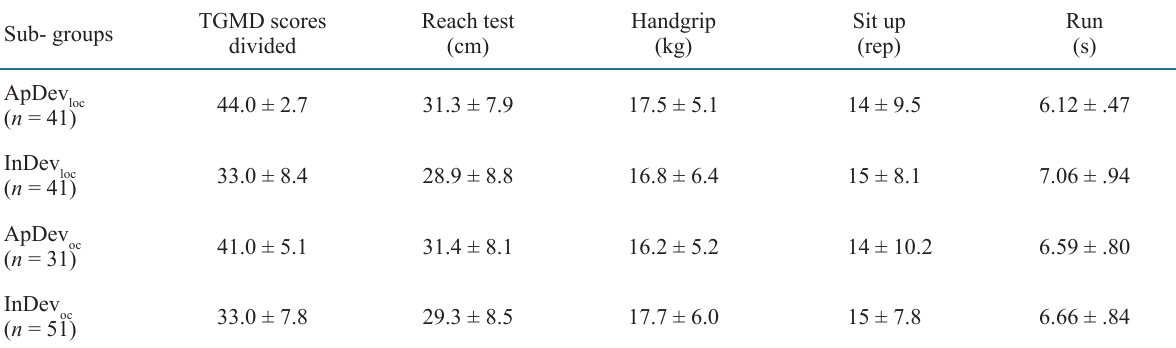
TGMD scores and physical fitness results divided according to the level of fundamental motor skill performance Sub-